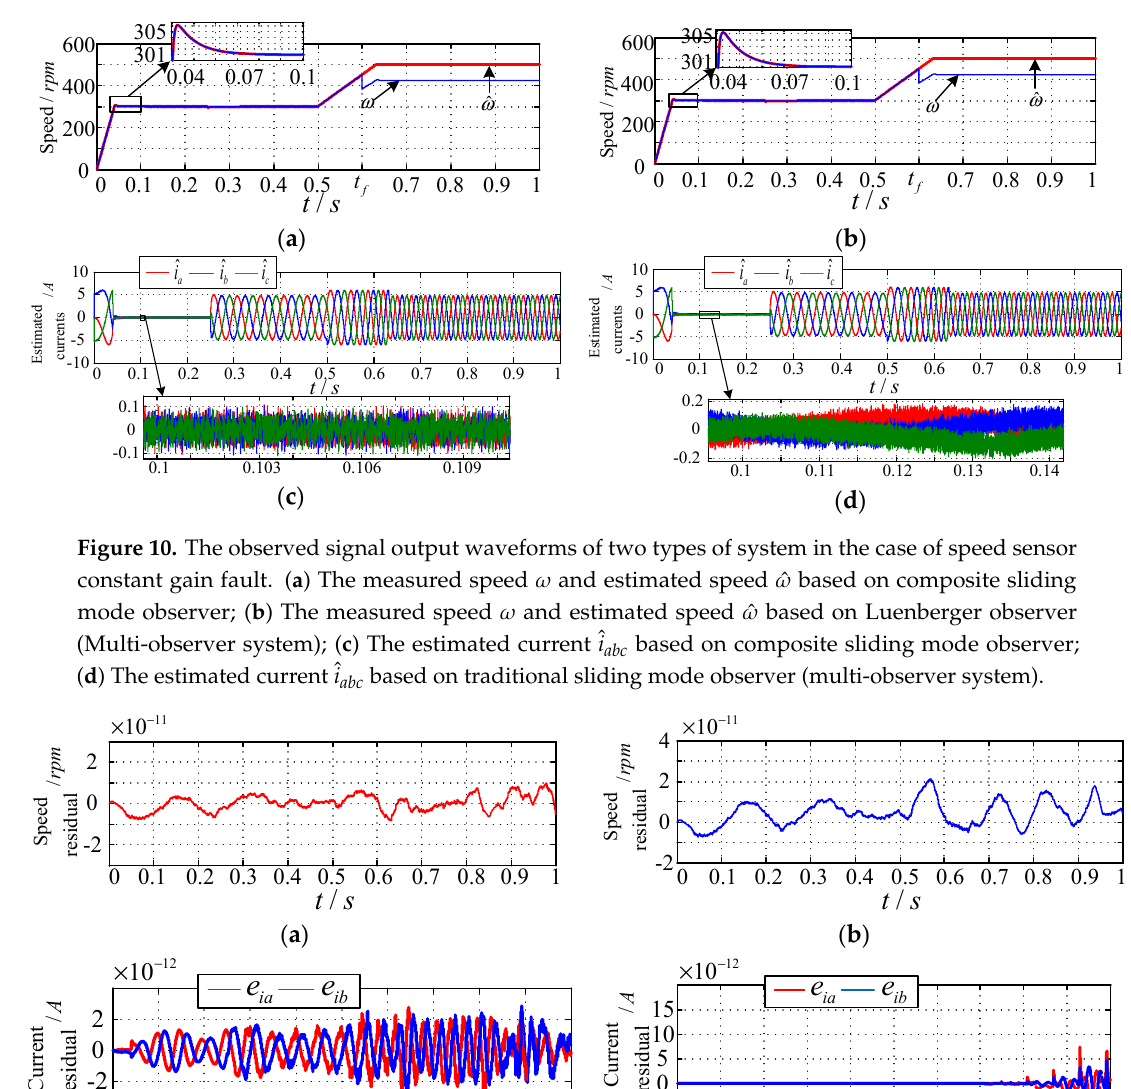
Figure 9. The observed signal output waveforms of two types of system when the a -phase current sensor is stuck. ( a ) The measured current i abc and estimated current 𝚤̂ (cid:3028)(cid:3029)(cid:3030) based on composite sliding mode observer; ( b ) The measured current i abc and estimated current 𝚤̂ (cid:3028)(cid:3029)(cid:3030) based on traditional sliding mode observer (Multi-observer system); ( c ) The estimated speed 𝜔(cid:3549) based on composite sliding mode observer; ( d ) The estimated speed 𝜔(cid:3549) based on Luenberger observer (multi-observer system).